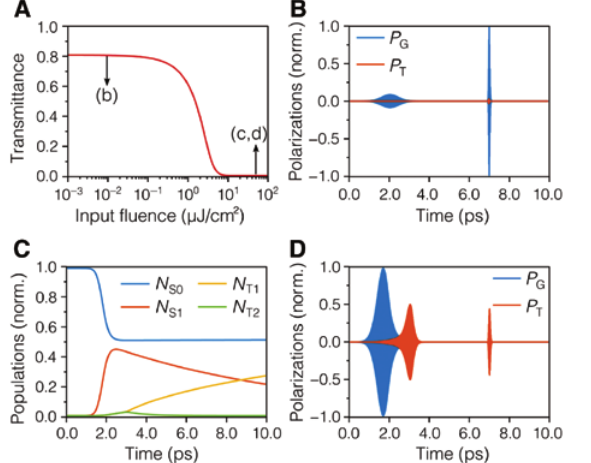
Figure 2: RSA behavior and time dynamics of the four-level system. (A) Transmittance vs. input fluence of a 1- μ m film. (B) Induced polarization densities inside the RSA at 0.01 μ J/cm 2 ; polarizations are governed by the ground state, as the triplet state contribution in the linear regime is negligible (not shown). Nonlinear regime time dynamics for a pump fluence of 50 μ J/cm 2 : (C) state densities and (D)